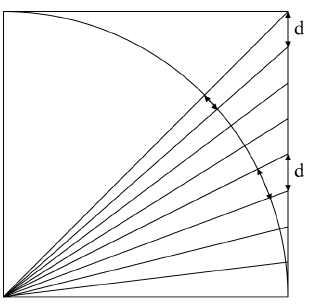
Figure 4. Cubemap